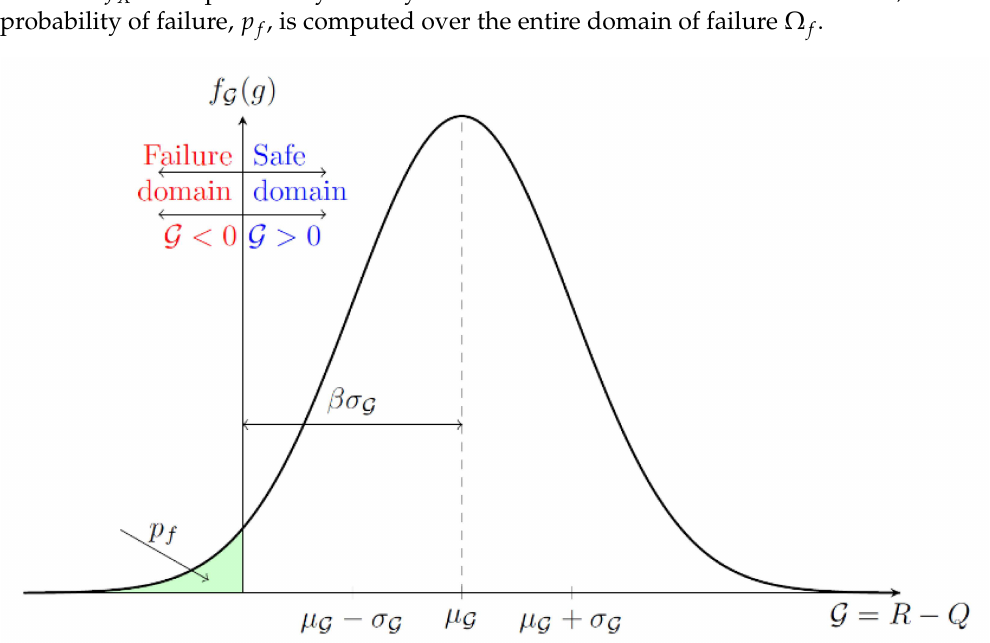
Figure 11. The reliability index is defined with regard to the safety